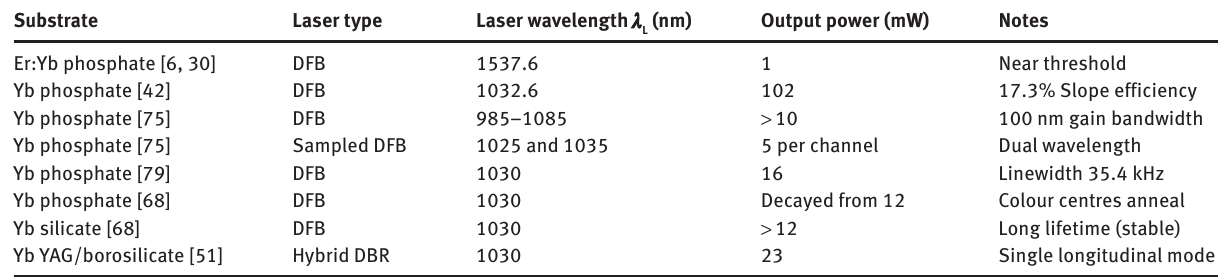
Table 2: Summary of the WGLs fabricated using ULI that use WBGs as a feedback element.